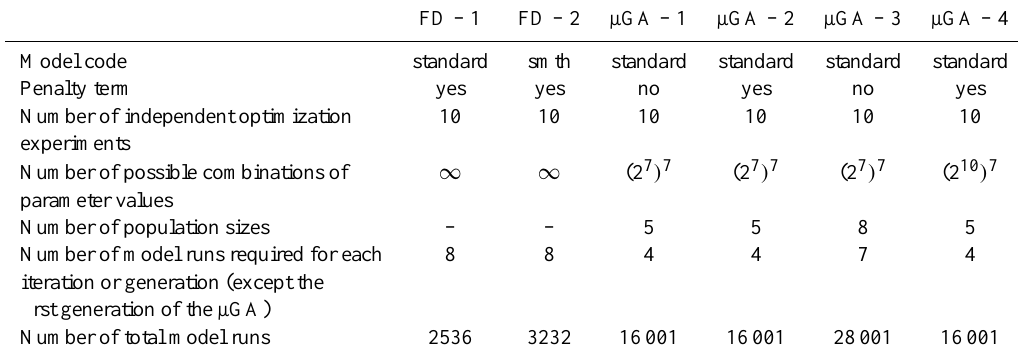
Table 3. Five series of optimization experiments with the FD and